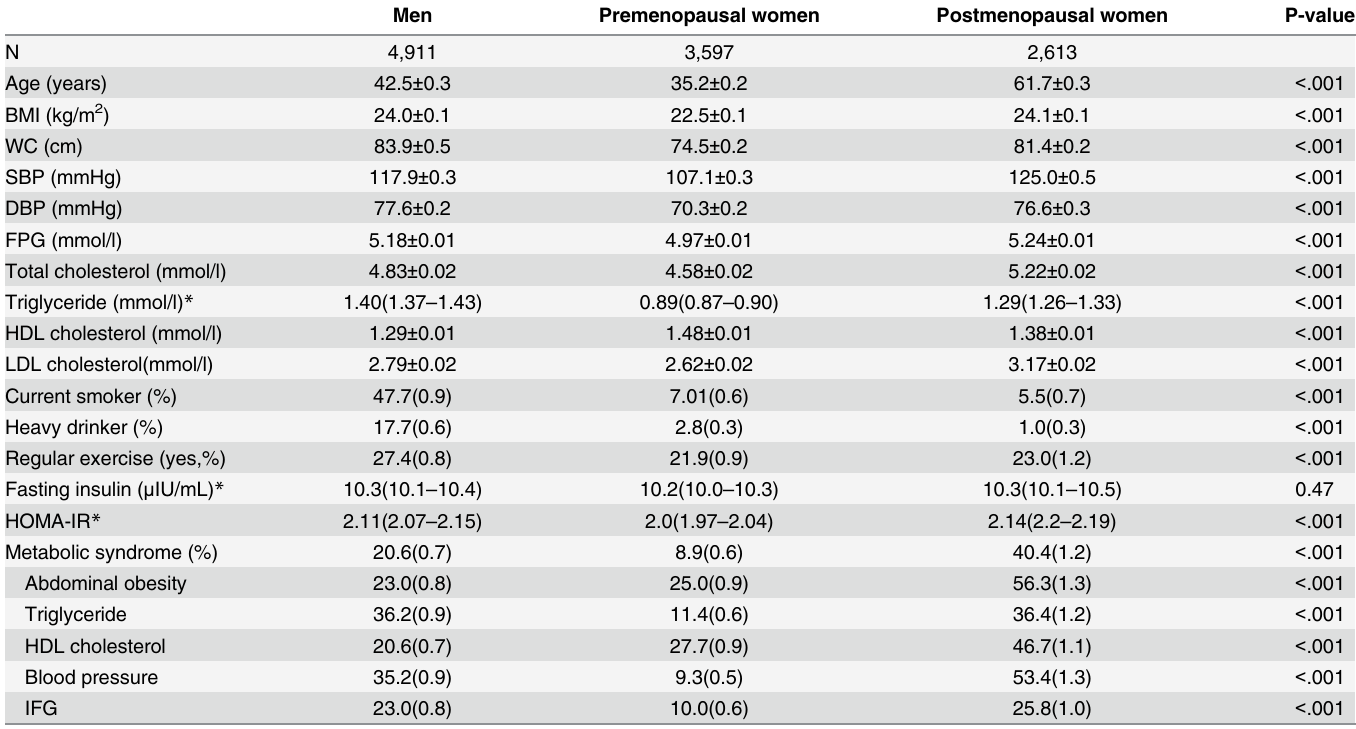
Table 1. Baseline clinical characteristics of the study